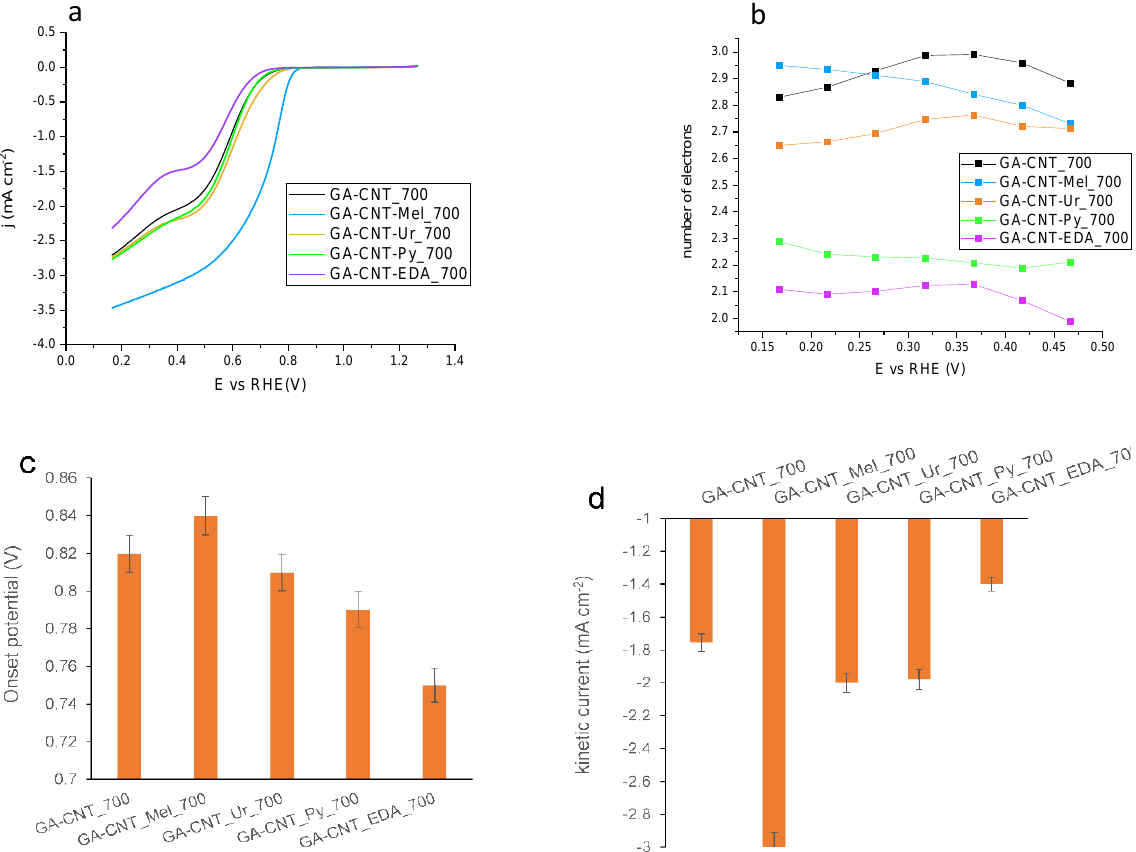
Figure 4. Effect of doping GA-CNT hybrids with different N-doping precursors pyrolysed at 700 °C: ( a ) LSV polarization curves in O 2 saturated 0.10 M KOH solution with a rotating rate of 1600 rpm; ( b ) interchanged number of electrons; ( c ) onset potentials; ( d ) and kinetic currents.